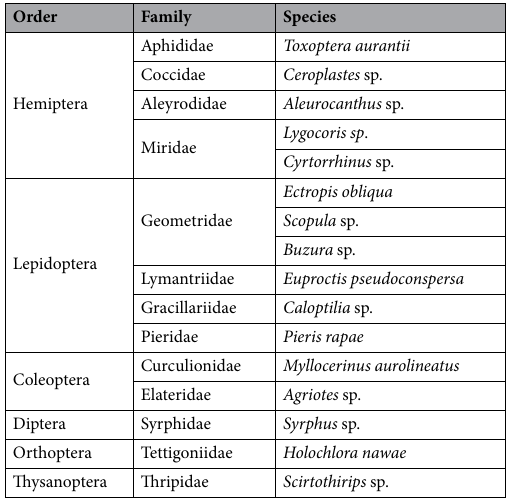
Table 1. The species which was chosen for cross reactivity to the assay.